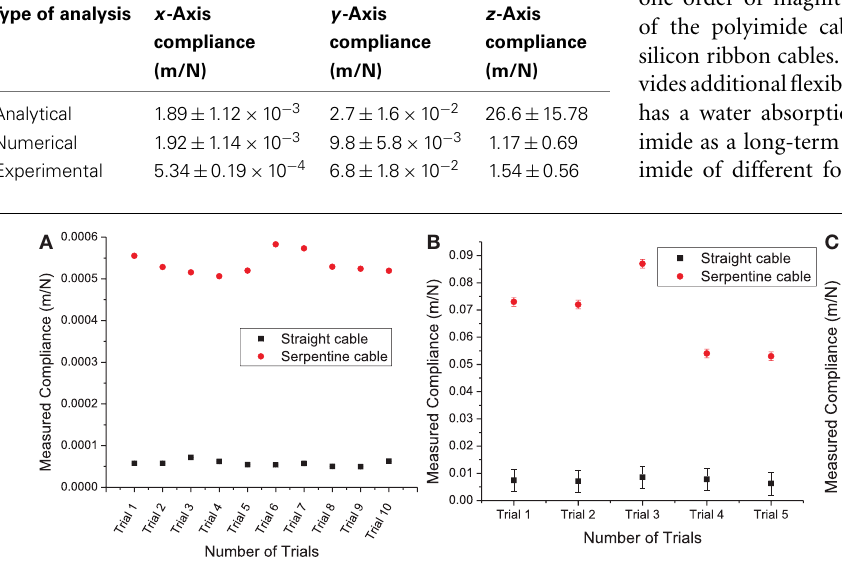
displacement drift during the loading period, and (C) measured z -axis compliance values from straight and serpentine cables.Transducer displacement drift during the loading period was nearly negligible (two orders of magnitude less) for straight and (four orders of magnitude less) for serpentine